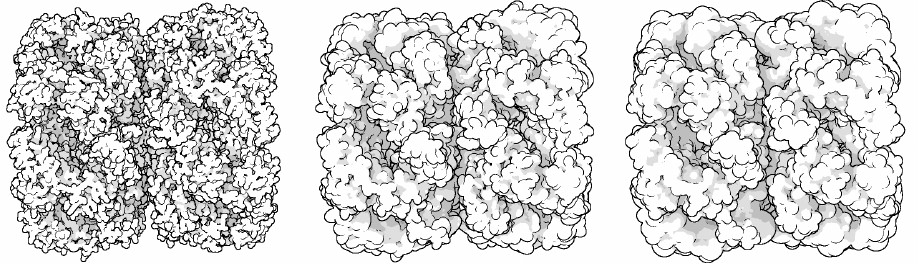
Figure 4. Comparison of three representation of the molecule (ID: 2EU1) performed using the vdW ( left ), bounding ellipsoid ( middle ) and the bounding sphere ( right ).